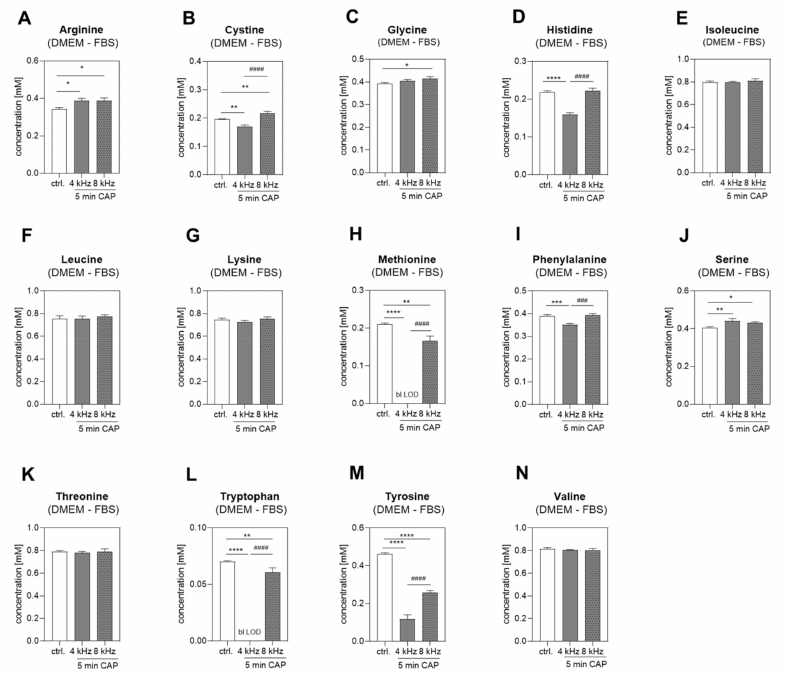
Figure 3. Amino acid concentrations in DMEM–FBS PTS. The concentrations of 14 amino acids ( A – N ) were measured by NMR spectroscopy in untreated DMEM–FBS (control), and in DMEM–FBS CAP treated at 4 kHz and 8 kHz for 5 min each (n = 3). Statistical analysis: Bonferroni’s multiple comparisons test. * p < 0.05, ** p < 0.01, *** p < 0.001, **** p < 0.0001 (4 kHz, 8 kHz versus control), ### p < 0.001, #### p < 0.0001 (4 kHz versus 8 kHz); bl LOD: below limit of